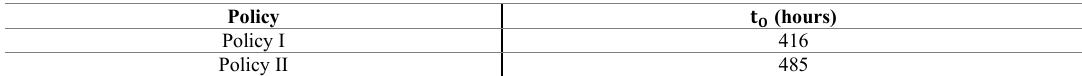
Table 2. Estimated optimal overhaul time for policies I and